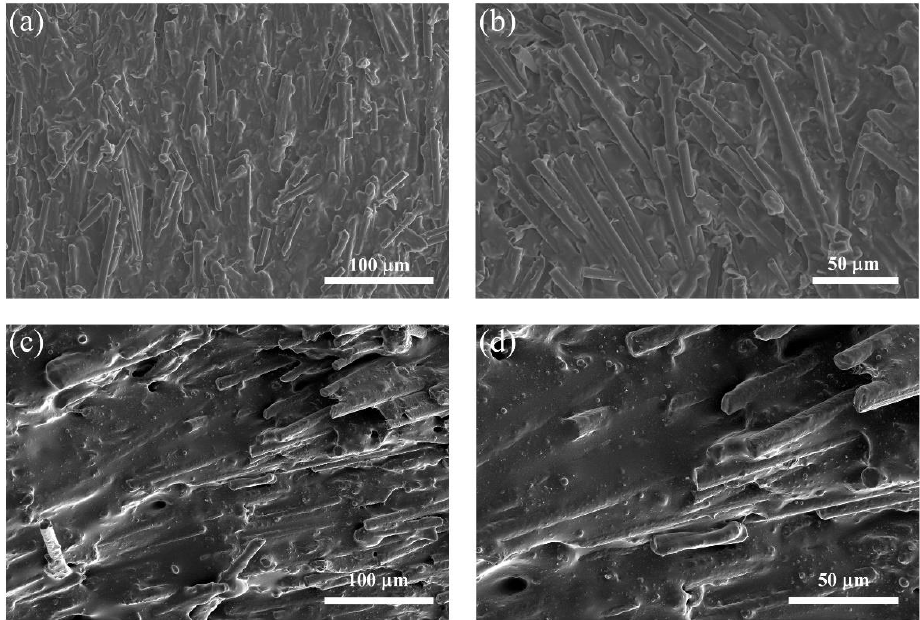
Figure 4. ( a , b ) Fracture surface SEM images of the PDMS/CF composite without alumina, ( c , d ) Frac- ture surface SEM images of the PDMS/alumina/CF composite.